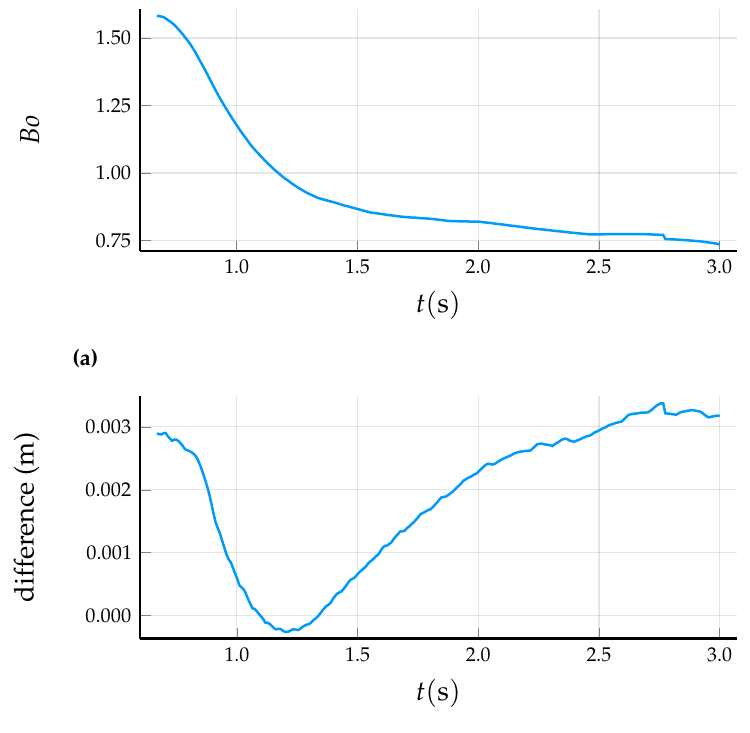
Figure 9. ( a ) Bond number calculated at the height of undercut for the surface tension case. ( b ) Difference between the surface tension and baseline cases. Bond number and differences from simulations presented in Figure 4. The lack of correlation between Bo and the difference occurs as velocity builds from the initial